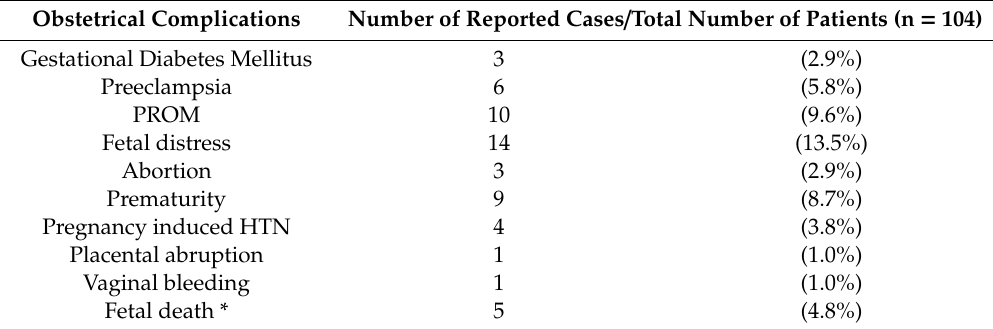
Table 6. Obstetrical complications of pregnant patients with